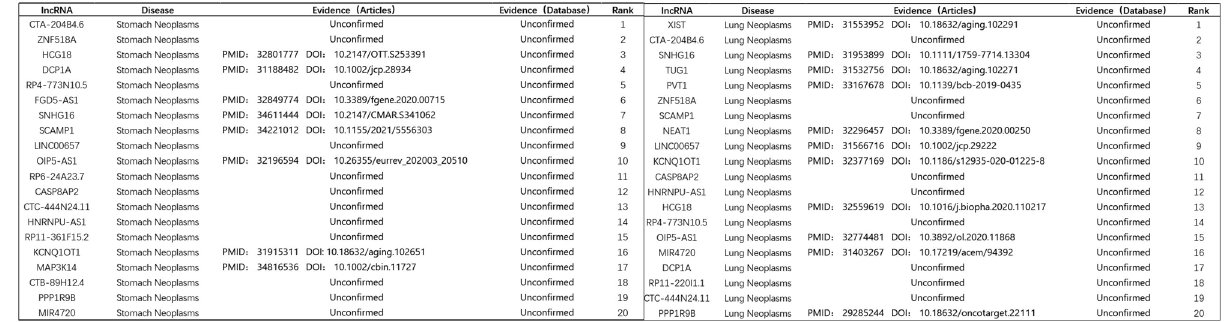
Figure 8. Validation results of lncRNAs predicted to be associated with stomach neoplasm (Left) and lung neoplasm